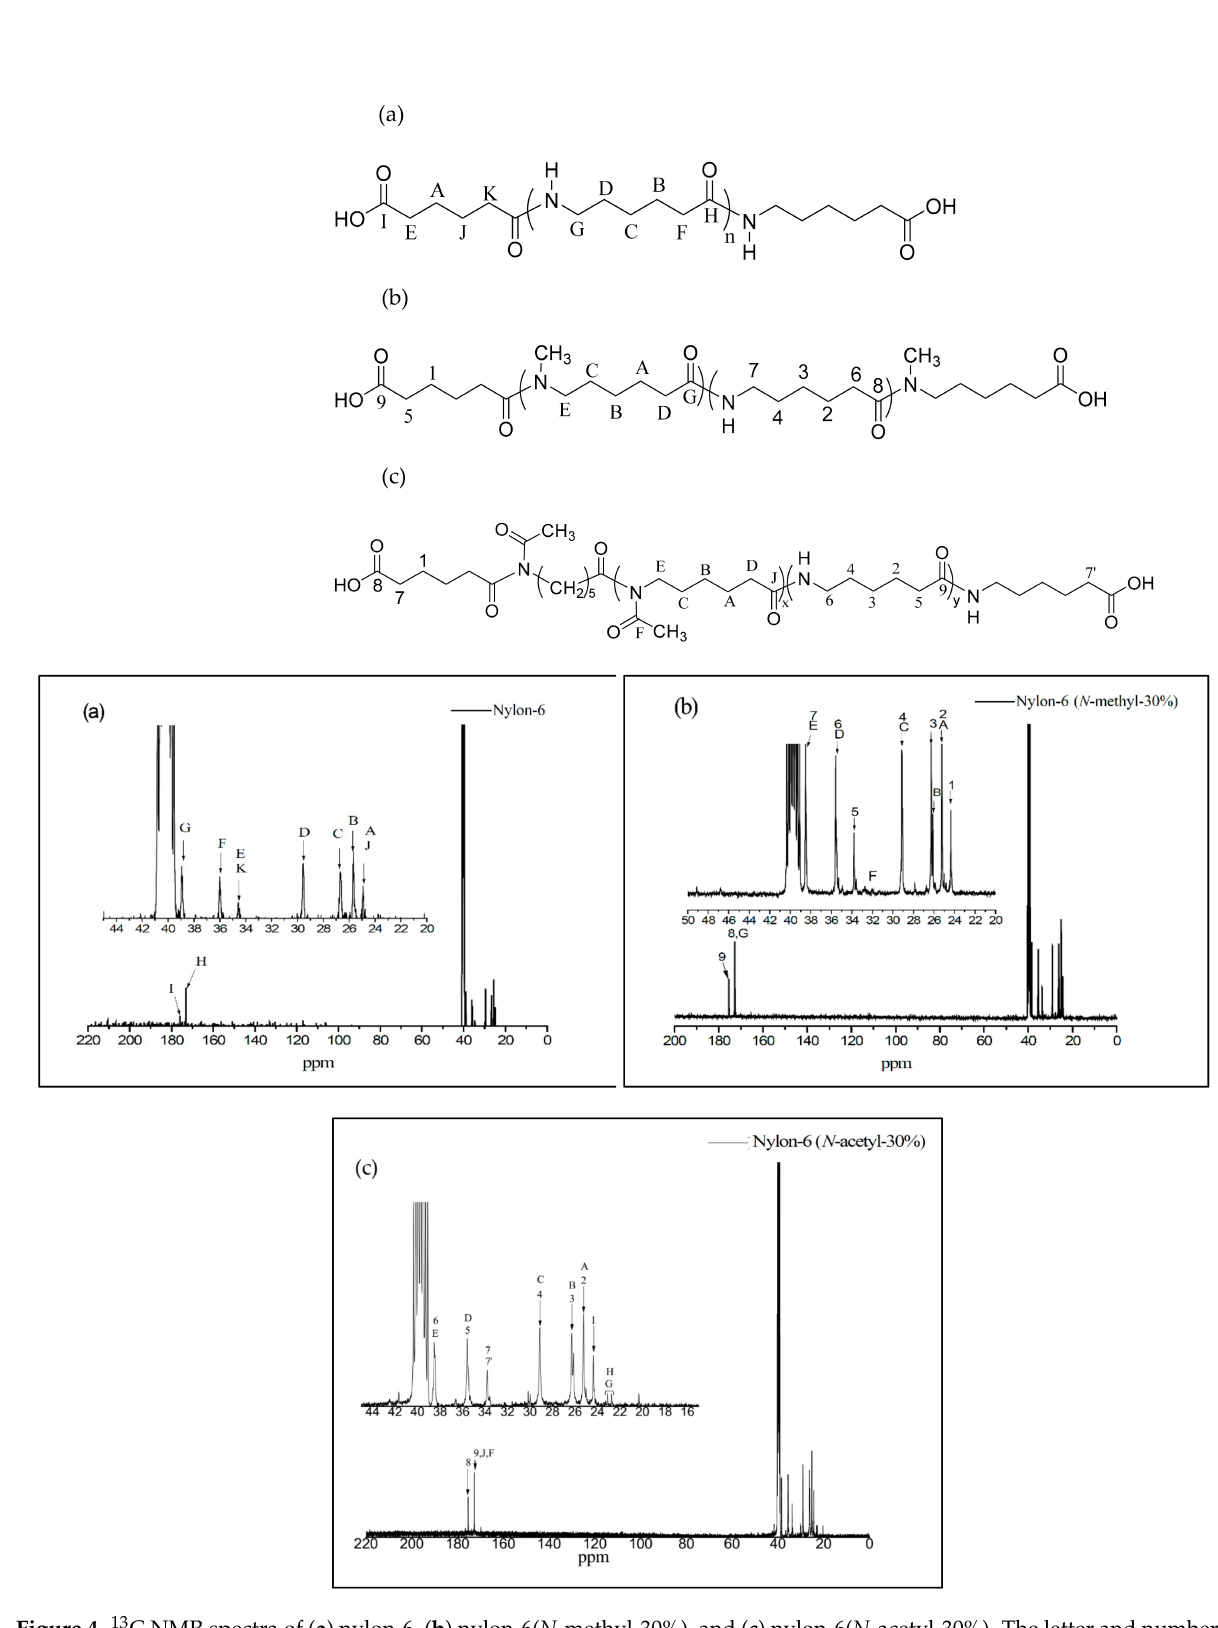
Figure 4. 13 C NMR spectra of ( a ) nylon-6, ( b ) nylon-6( N -methyl-30%), and ( c ) nylon-6( N -acetyl-30%). The letter and number represent chemical shift of each structural